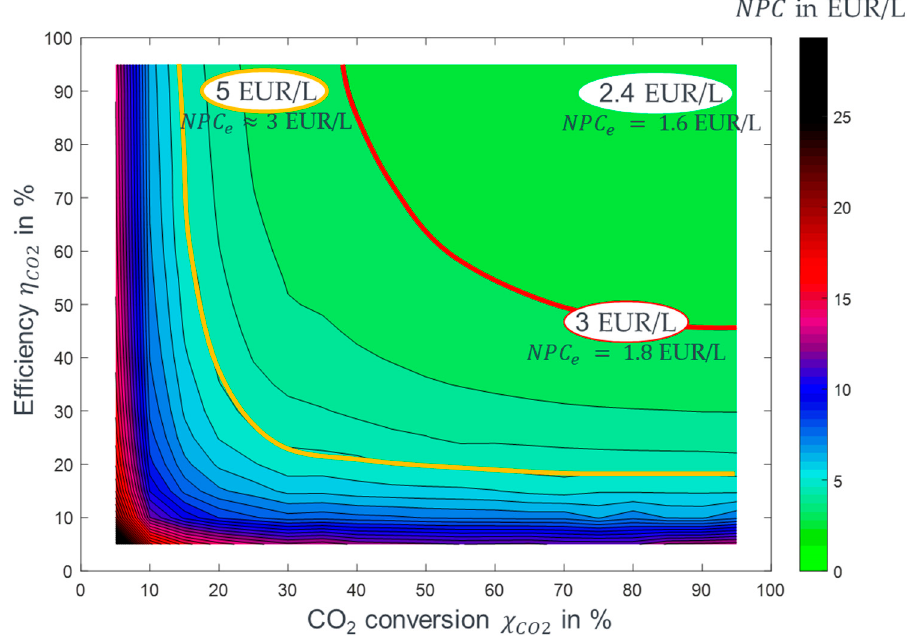
Figure 15. Net production costs (NPC) as a function of CO 2 conversion and energy efficiency; η EL = 90%, high-performing GDE.